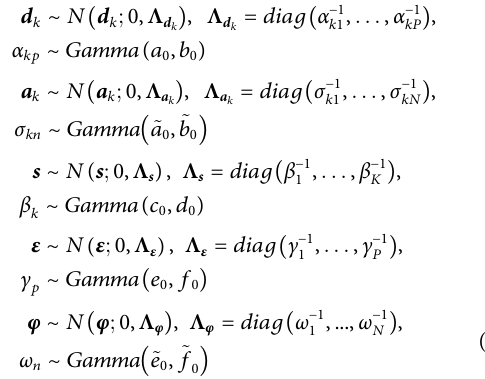
TABLE 5 Con fi guration of Inspur NF5280M5 server. De fi nition Con fi